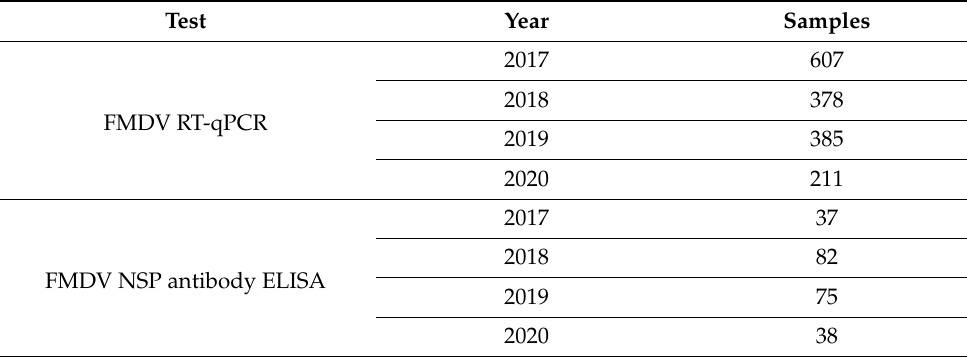
Table 4. Total number of FMD tests at regional laboratories from 2017 to